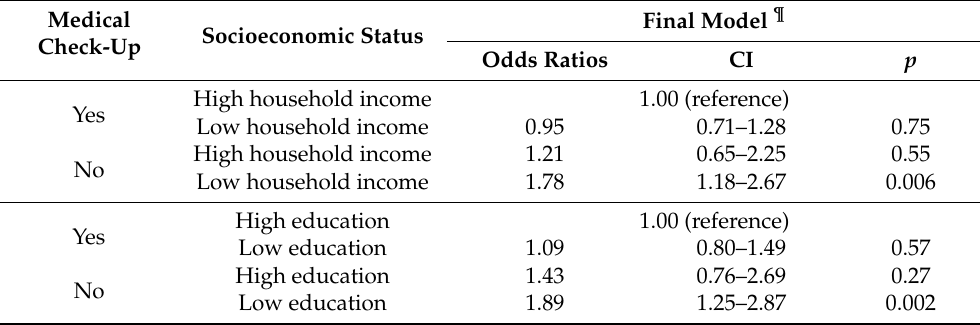
Table 4. Participating in medical check-ups over the past 2 years according to